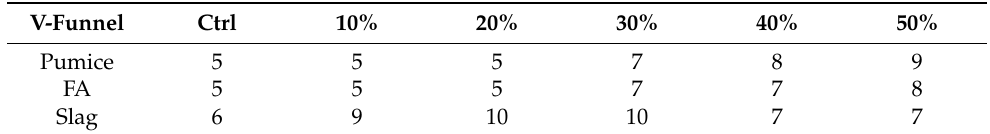
Table 2. V-funnel test value for each binary samples.